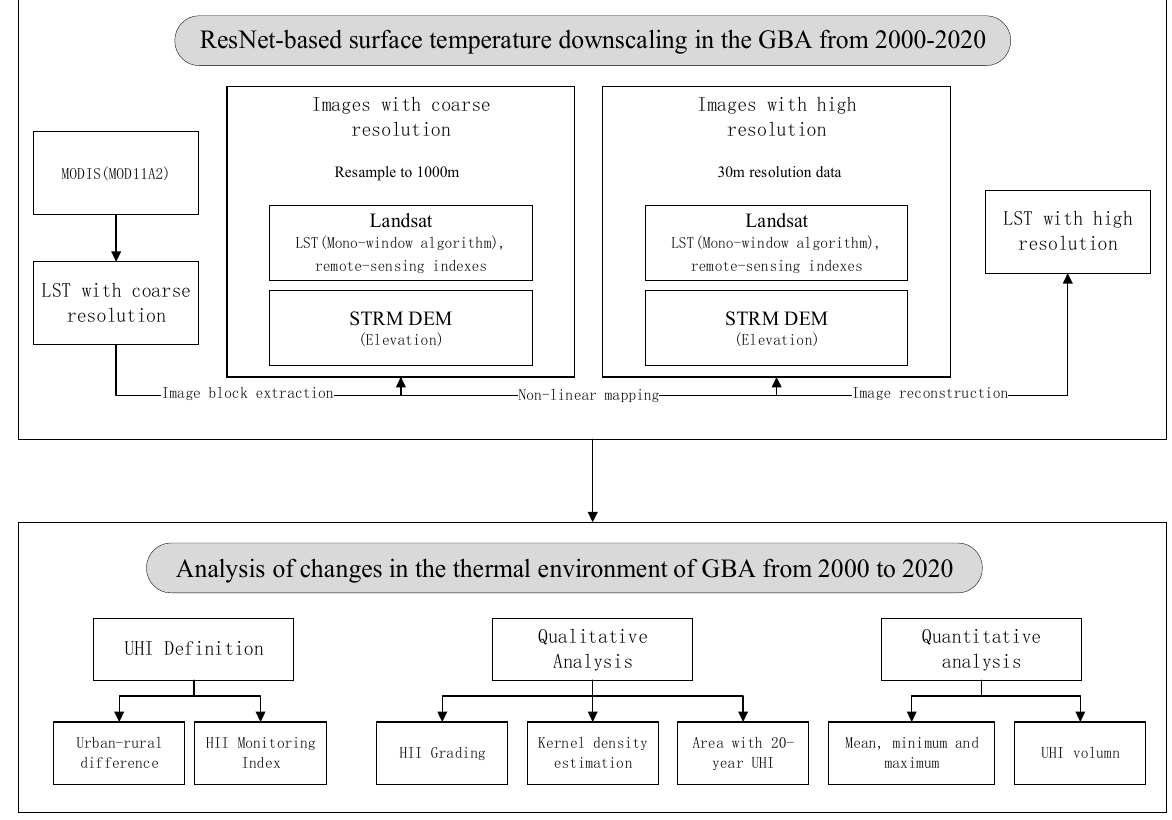
Figure 2. Technical flow chart.